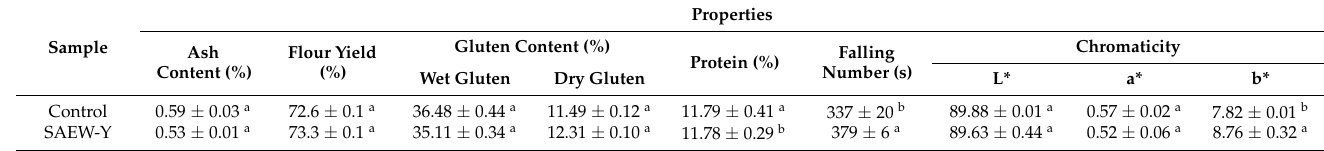
Table 2. Evaluation of physical and chemical quality of wheat flour tempered by distilled water (control) and SAEW.